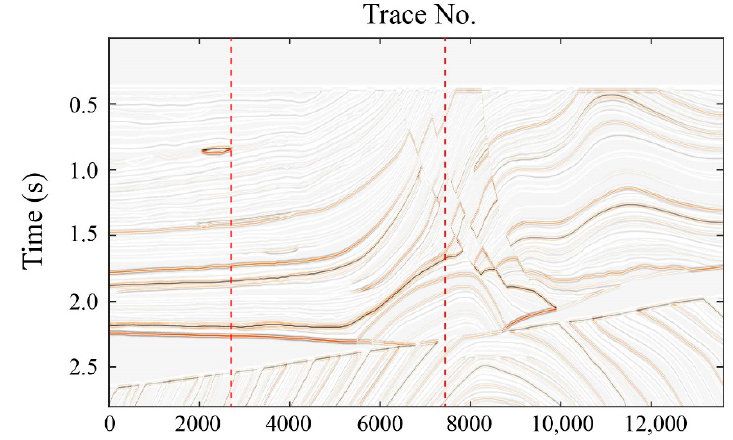
Figure 3. Synthetic seismic data profile of Marmousi2.